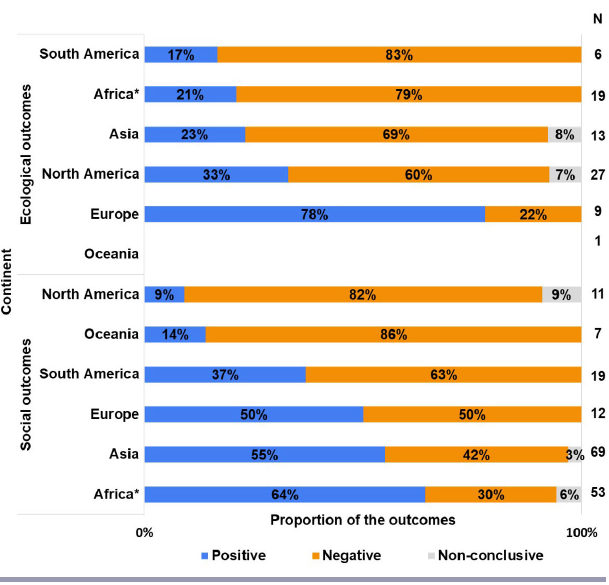
Fig. 4 . Ecological and social outcomes of urbanization on regional farming systems across continents (* Outcomes are statistically significant at p < or =